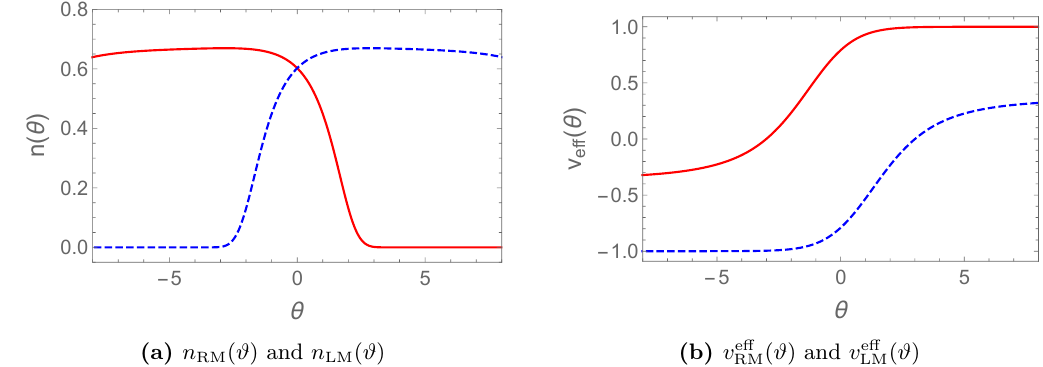
Figure 2. (a) Filling function of right-moving (red continuous curve) and left-moving particles (blue dashed curve) and (b) the e(cid:11)ective velocities of the right-moving (red continuous curve) and left-moving (blue dashed curve) particles in the D 4 (cid:13)ow in a thermal state with T=M = 1 : 4.